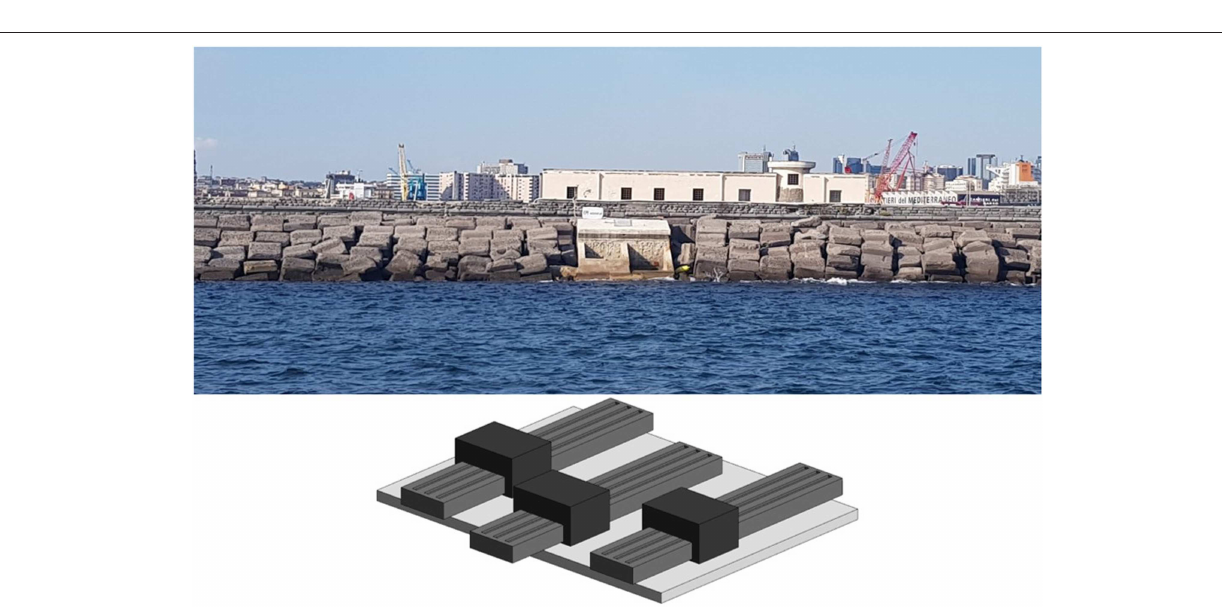
by many single modules. Every module generates about 3 kW (SINN Power GmbH Wave Energy, 2017). In December 2015, SINN Power started operating the first wave energy